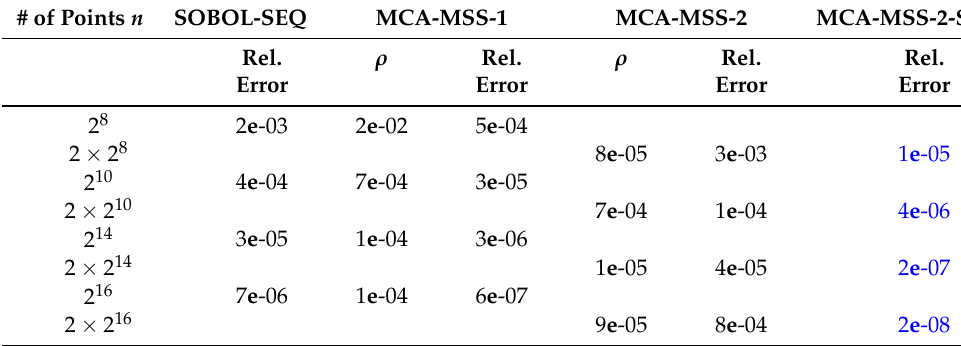
Table 2. RE for AE of f 0 ≈ 0.048.